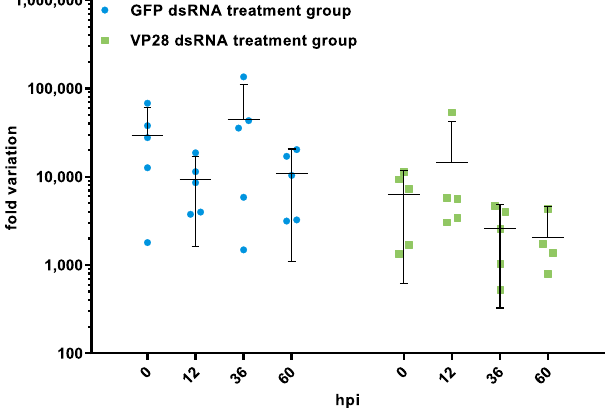
Figure 1. Detection of injected dsRNA in experimental animals. Shrimp (2.618 g ± 0.527 SD, n = 30) injected with 42.85 µ g dsRNA were sampled (n = 5) at indicated time points, and dsRNA levels were measured by RT-qPCR using assays with specificity for the injected treatments. Another experiment verified that when using primers nonspecific for the VP28 dsRNA treatment, but with specificity for VP28 mRNA, no Cq-values were obtained through 40 cycles for shrimp in the VP28 dsRNA treatment group. One-way ANOVA did not reveal any significant changes between groups or time points at α = 0.05 (p = 0.255). Error bars indicate the 95% CI around the